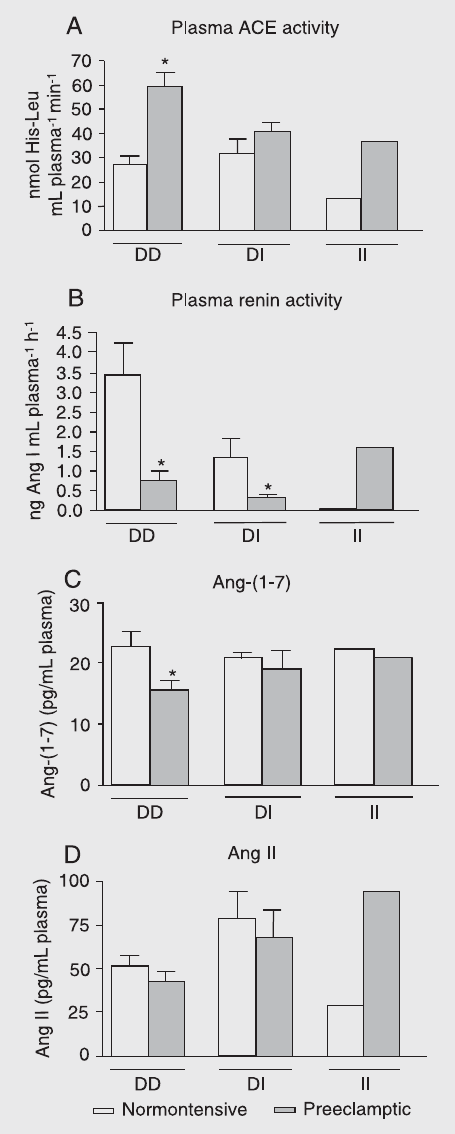
Figure 2. Plasma angiotensin- converting enzyme (ACE) activ- ity (A), plasma renin activity (B), plasma angiotensin-(1-7) (Ang- (1-7)) levels (C), and plasma